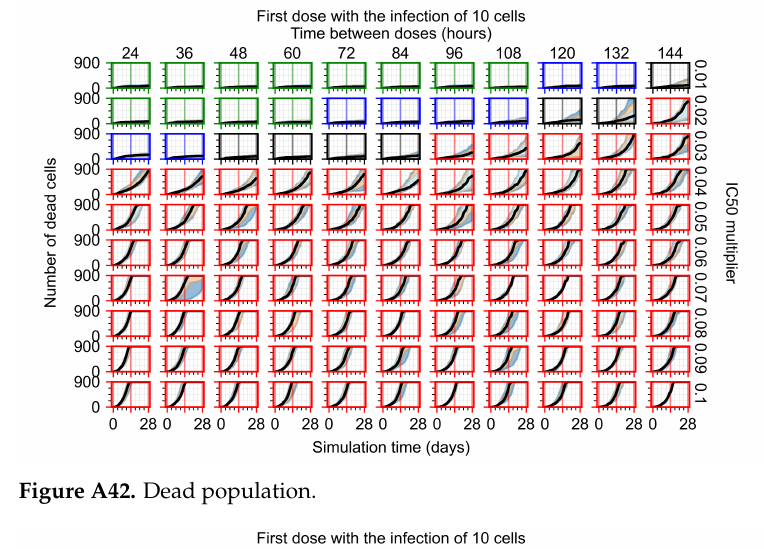
Figure A41. Infected (secreting extracellular virus) population.